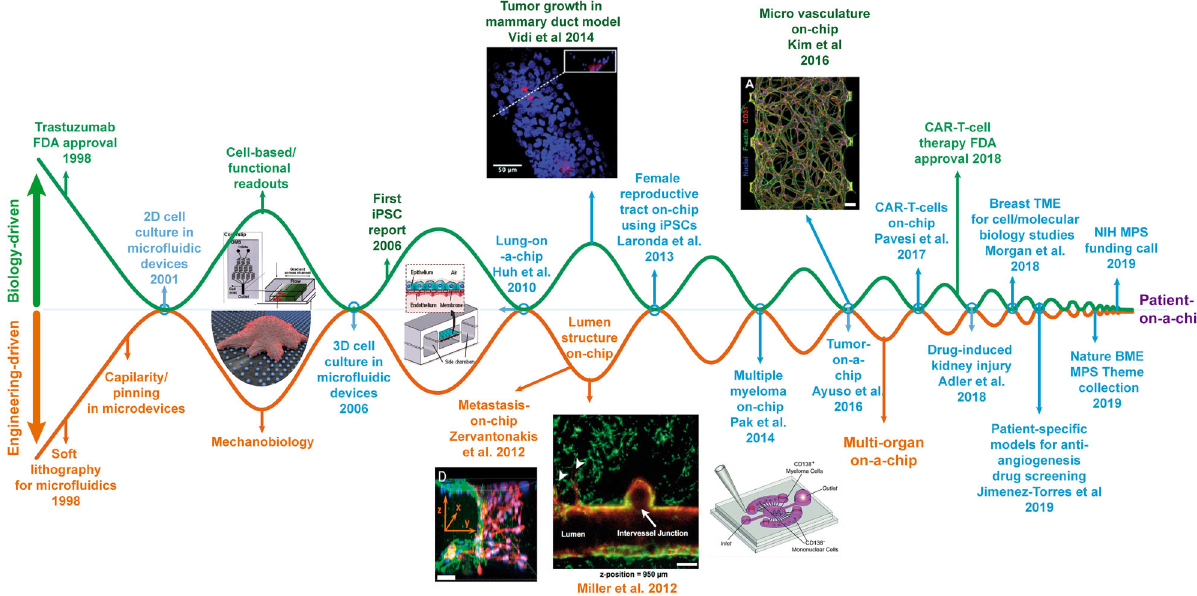
Fig. 2 Timeline of intersections between biology (green) and engineering-driven (orange) research. The fi gure illustrates the rising tendency since the 2000s of increasingly translational publications (blue) that have brought us closer to patient-on-a-chip models. A number of recent publications provide a more detailed review of speci fi c technical advances 26,97,121,123 – 127